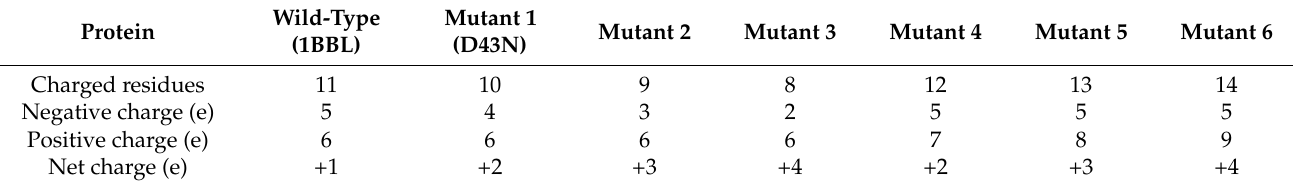
Table 2. Charged details of wild-type protein and